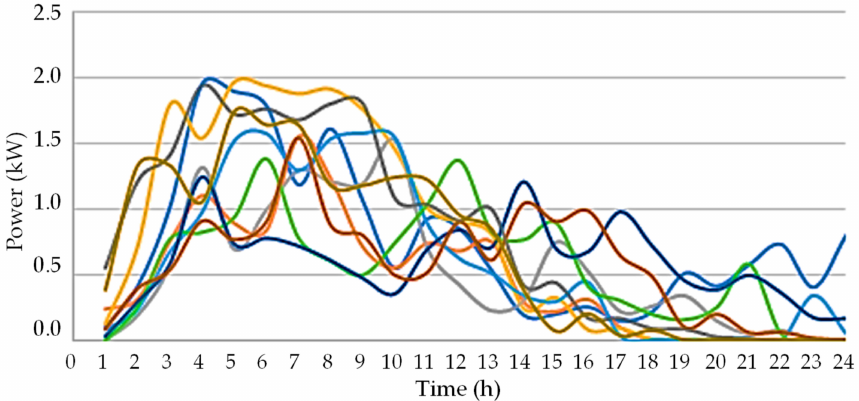
Figure 1. Di ff erent wind power scenarios used in the proposed analysis model.